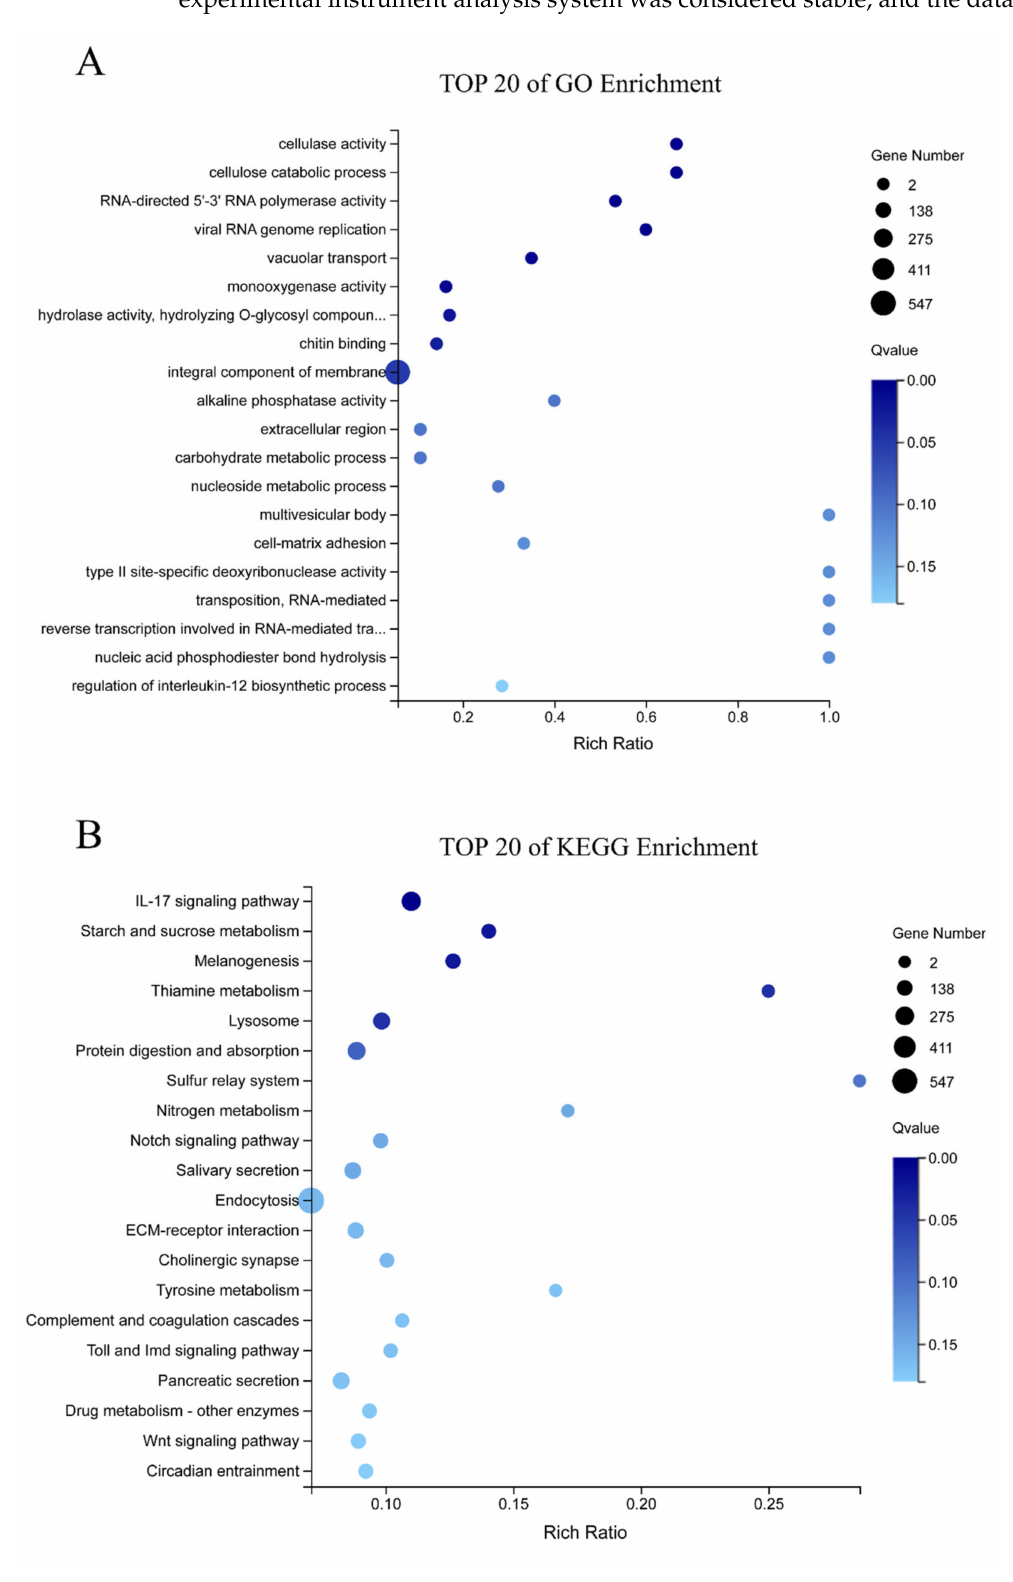
Figure 3. Top 20 GO and KEGG pathways significantly enriched with differentially expressed genes (( A ) top 20 of GO enrichment; ( B ) top 20 of KEGG